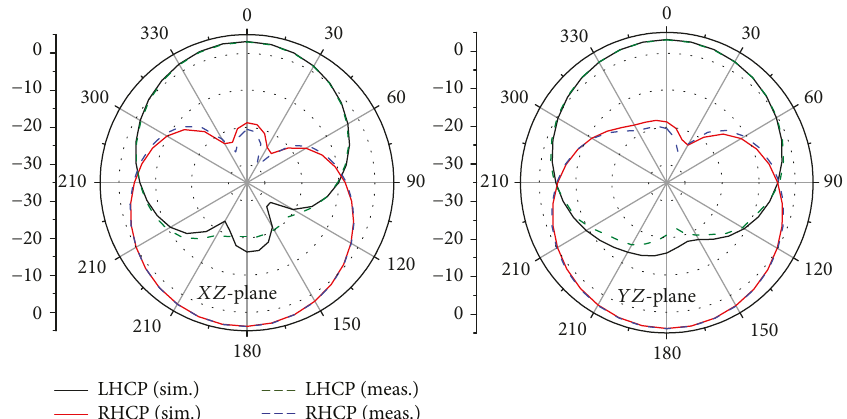
Figure 11: Simulated and measured radiation patterns at 900MHz.